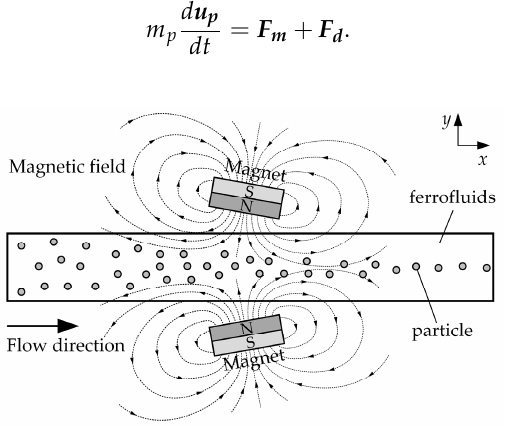
Figure 2. Schematic of the particles focusing mechanism. When two rectangular permanent magnets are placed at the center of a channel length with the same opposite polarity, and its direction of magnetization perpendicular to the channel wall, the magnet field magnetizes the ferrofluids within the microchannel and subsequently affects the particle motion.